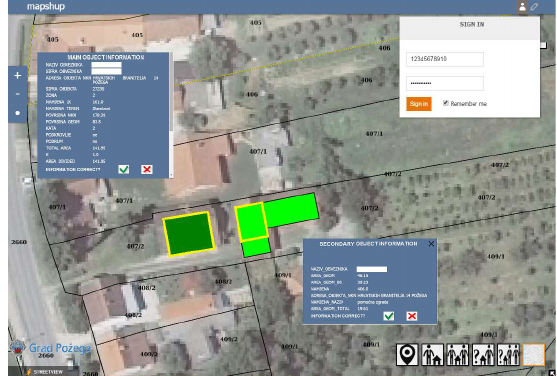
Figure 9. Example of spatial inconsistency of reference LM and cadastral data resulting in wrong or none owner